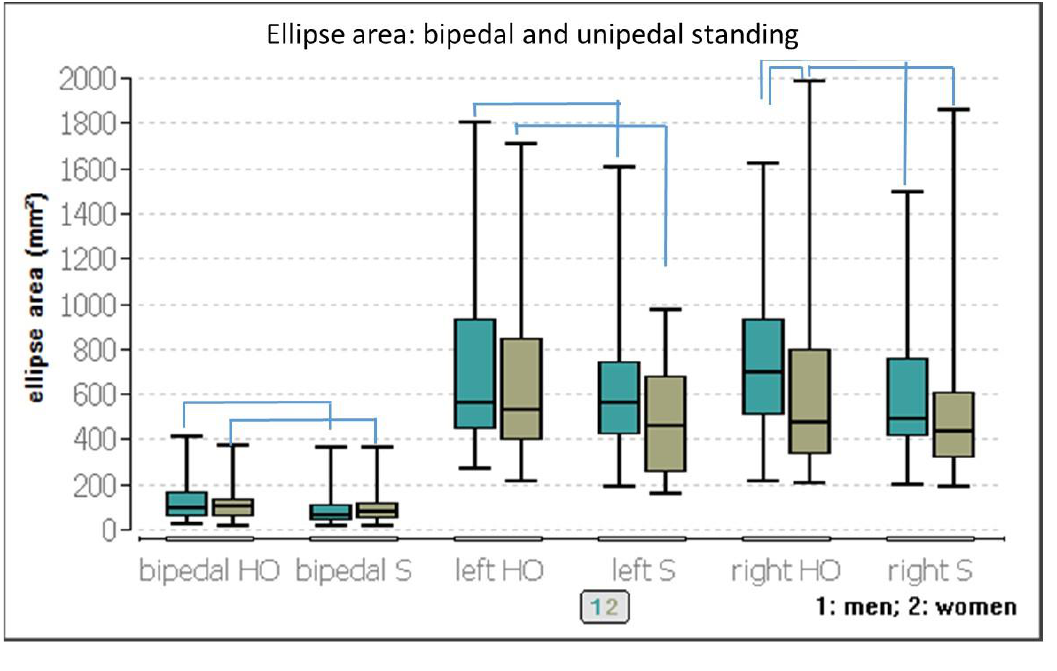
Figure 1. Ellipse of CoP while bipedal and unipedal standing (left/right leg) with either habitual occlusion or splint, separated into male and female subjects.